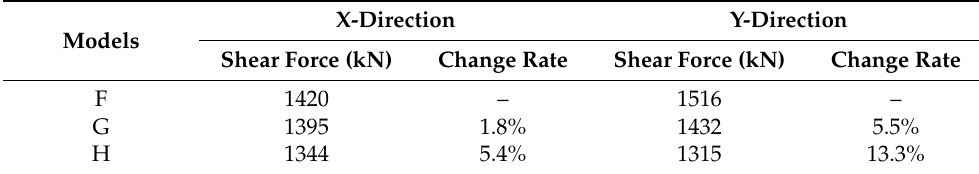
Table 15. A comparison of the maximum base shear of the models. Models